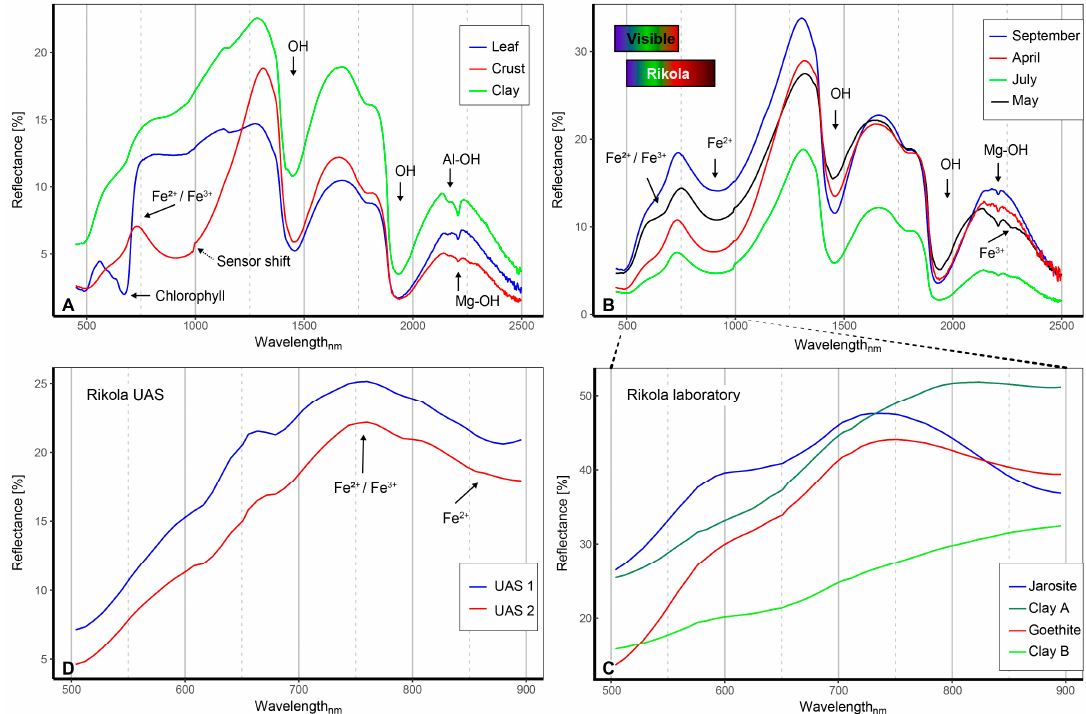
Figure 6. Examples of different spectra, selected during the Litov field campaigns. Frame ( A , B ) show the field spectra, obtained with the Spectral Evolution spectroradiometer. Frames ( C , D ) illustrate spectra acquired with the Rikola HS camera. UAS 1 and 2 refer to two different points in the same HSI.